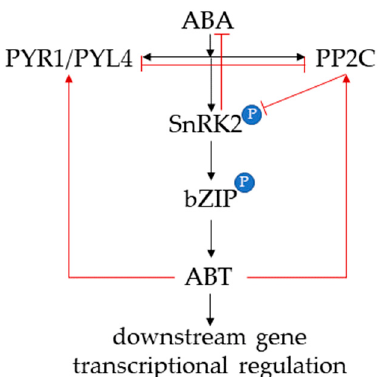
Figure 2. ABA signal regulatory pathway mediated by ABT. Arrow “ → ” indicates induction or promotion, while bar “ ˧ ” indicates inhibition. In the presence of ABA, PYR1/PYL4 binds to PP2C and activates SnRK2s, leading to phosphorylation of bZIP transcript factors and activation of the expression of ABA-responsive genes, including ABT (ABA Signaling Terminator). ABT interacts with both PYR1/PYL4 and PP2C proteins and disturbs the interaction between PYR1/PYL4 and PP2C proteins to decrease the inhibitory influence of PYR1 on the phosphatase activity of PP2C proteins. As a result, PP2C proteins inhibits SnRK2s autophosphorylation, which switches off ABA signaling, leading to downstream gene transcriptional